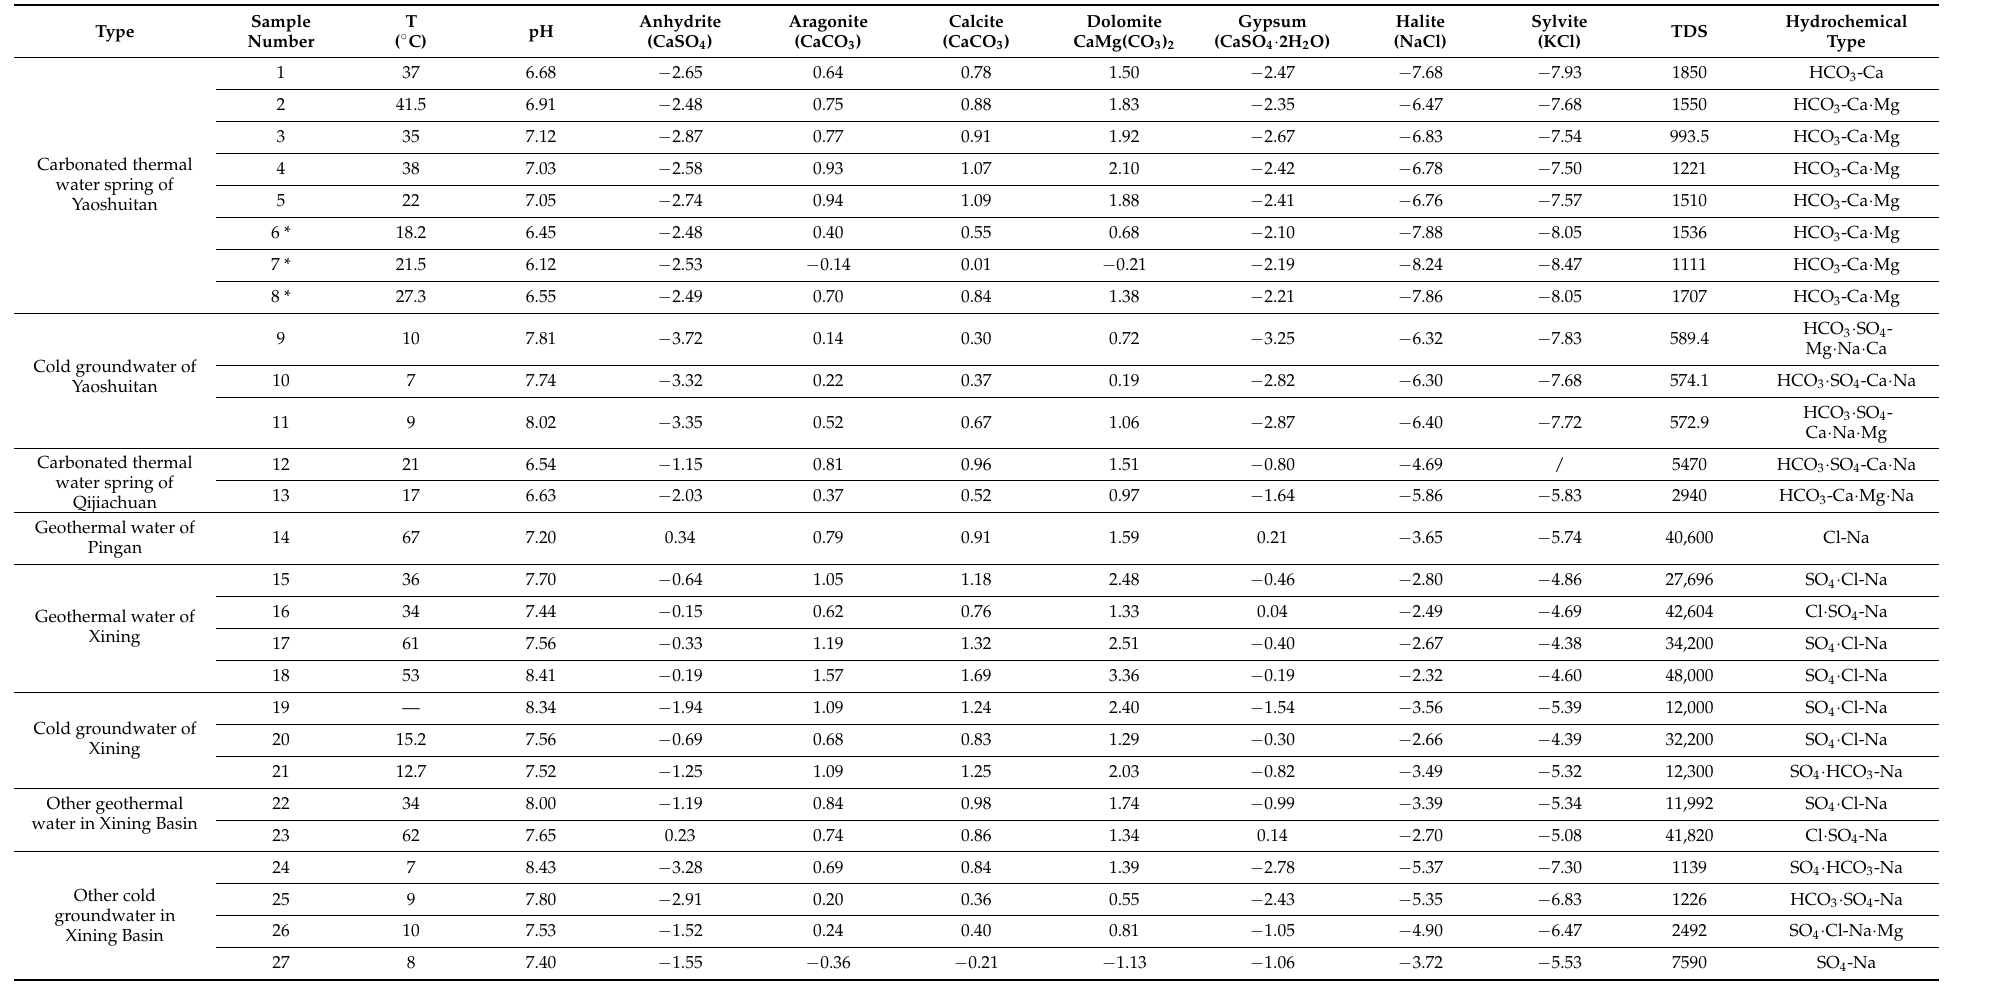
Table 2. Saturation index of main minerals in carbonated thermal water spring, geothermal water, and groundwater in Xining